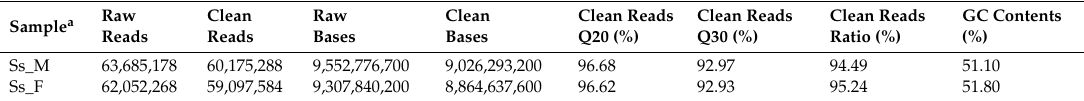
Table 1. Summary statistics of Sillago sihama gonad transcriptome sequencing data.